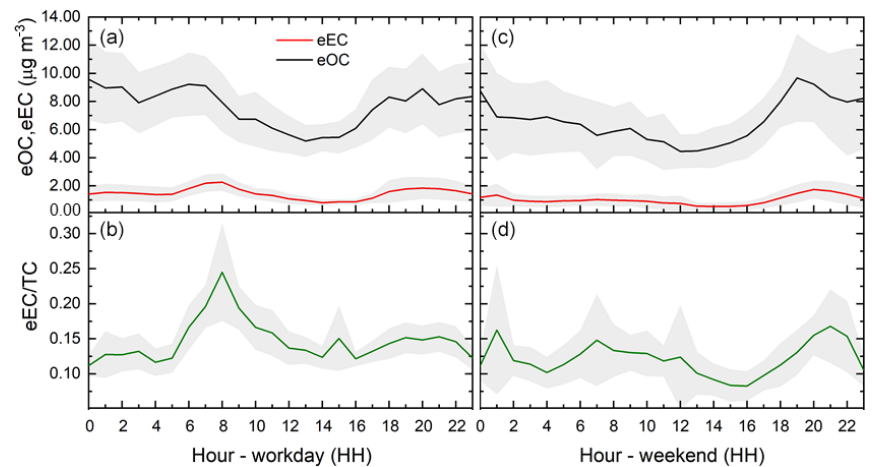
Figure 12. Hourly diurnal profiles for workday (a, b) and weekend (c, d) for eOC (black line) and eEC (red line) and average-eEC-to- average-TC ratio (green line). The shaded gray area represents the 95% confidence interval around the mean value. Time is local